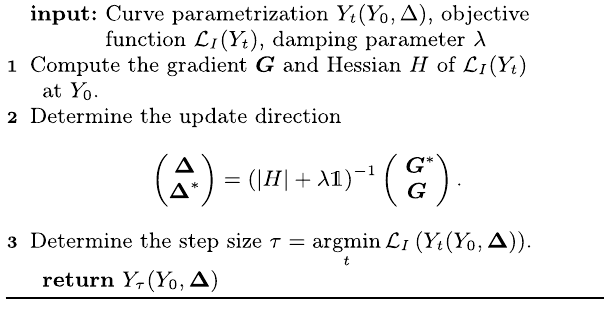
Algorithm 1. SFN